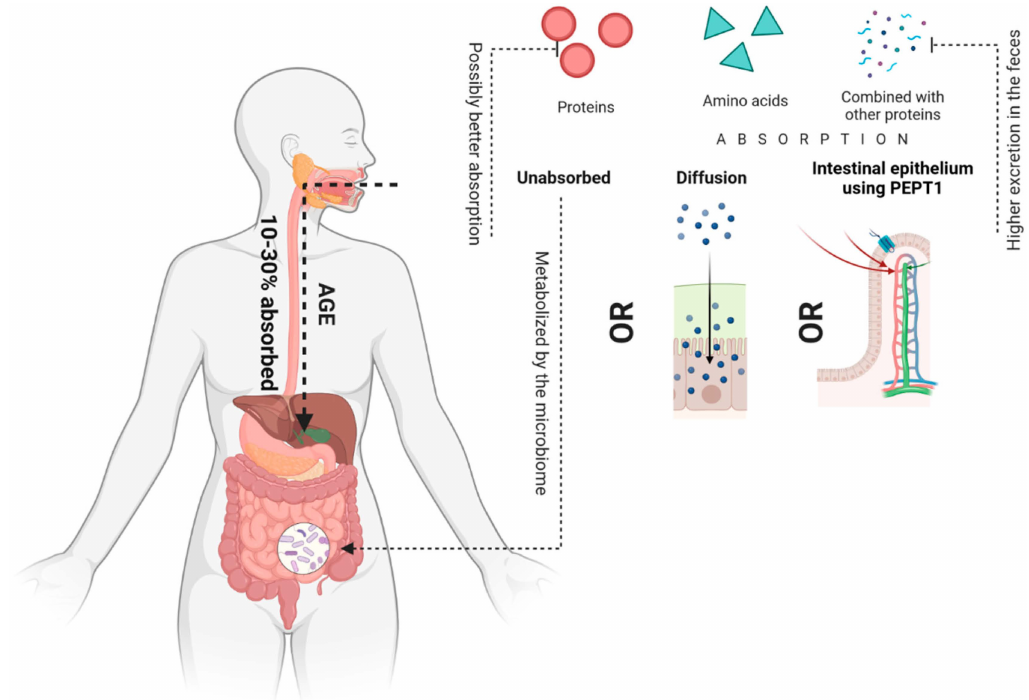
Figure 3. AGE absorption through the gastrointestinal tract.